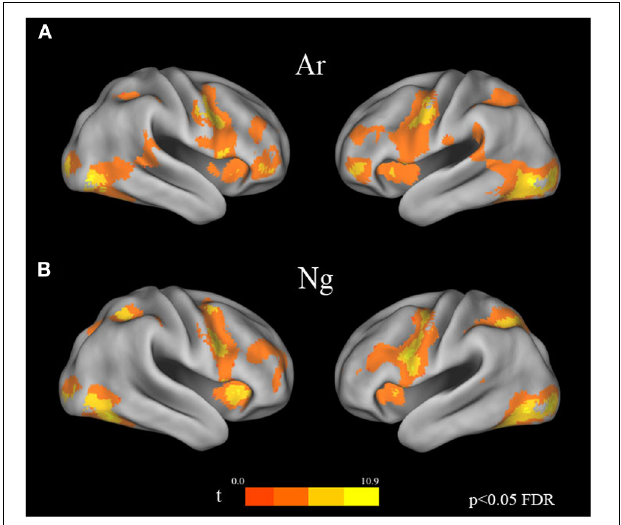
FIGURE 4 | (A) Brain activation maps for Ar and Ng number comparison tasks. All maps are masked by their respective number identification masks. Statistical maps were corrected for multiple comparisons (FDR correction at p < 0 . 005). (B) Effect of task difficulty. Brain regions activated in Nagari as compared to Arabic contrast (FDR, p < 0 . 005) masked by Ar and Ng identification mask. A reverse Arabic > Nagari contrast, did not reveal activations in any brain area. Regions of the Fronto-parietal network with increased activation are outlined in